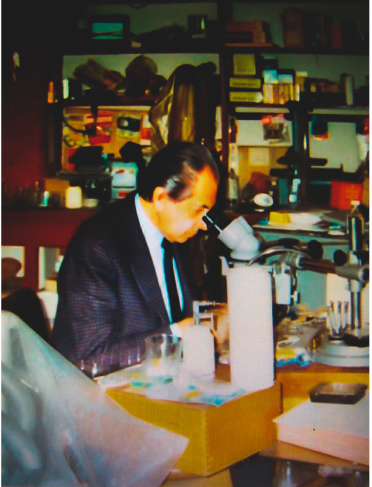
Figure 1. Prof. Salom ó n